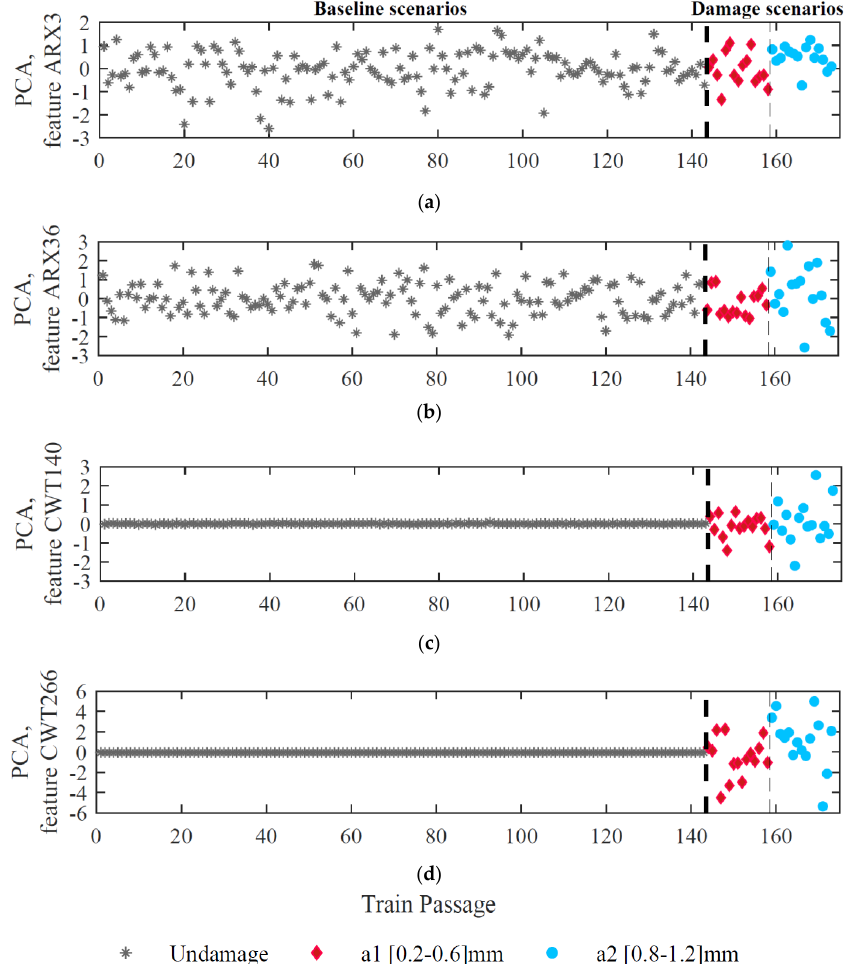
Figure 14. Feature normalization for sensor 1, ( a ) ARX–PCA–based feature 3, ( b ) ARX–PCA–based feature 36, ( c ) CWT–double–PCA-based feature 140, ( d ) CWT–double–PCA–based feature